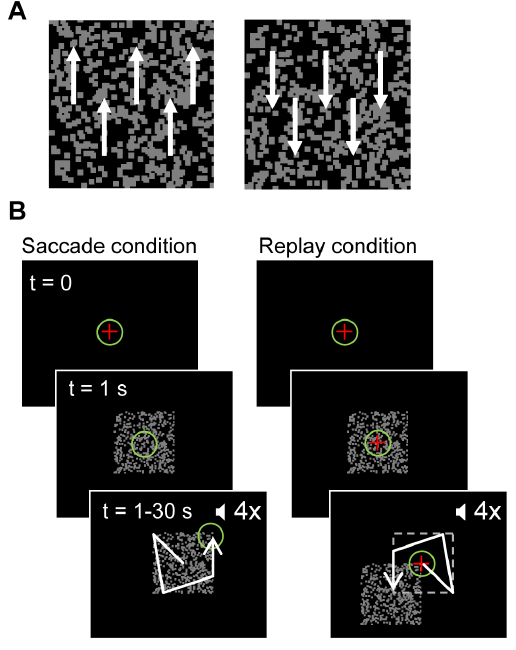
Figure 1. Stimulus and paradigm. A: Example of the motion stimulus used in this study. The arrows indicating motion direction in the left and right eye were not present in the real stimulus. B: Time course of a saccade trial and a replay trial. Each trial starts with the presentation of a central fixation cross. After 1 second, the dichoptic stimulus appears, and the subject starts judging motion direction. During the rest of the 30 s trial, either the gaze or the stimulus moves while the subject keeps indicating the perceived motion direction. Four auditory cues per trial were used in the saccade trials to indicate saccade moment. These cues were also presented in the stimulus jump trials, where they served as a warning for upcoming large stimulus jumps. + fixation point, O subject’s gaze, auditory cue. White arrow: illustration of possible gaze path in saccade trials and corresponding stimulus path in replay